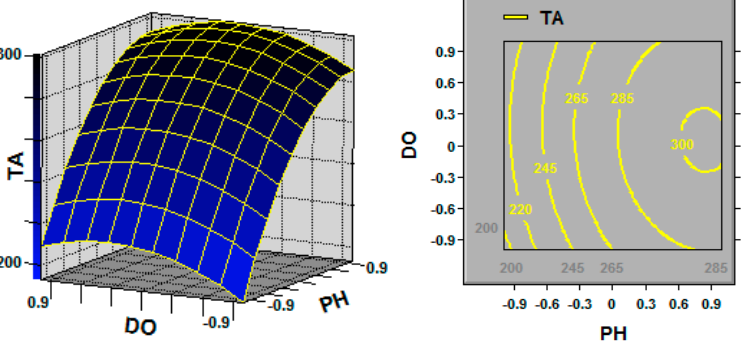
Figure 1. Response surface curve ( left ) and contour plot ( right ) for triterpene acid (TA; mg/L) production illustrating the interaction between the initial pH (pH) and dissolved oxygen (DO) at the coded levels. Fixed level: temperature = 0.